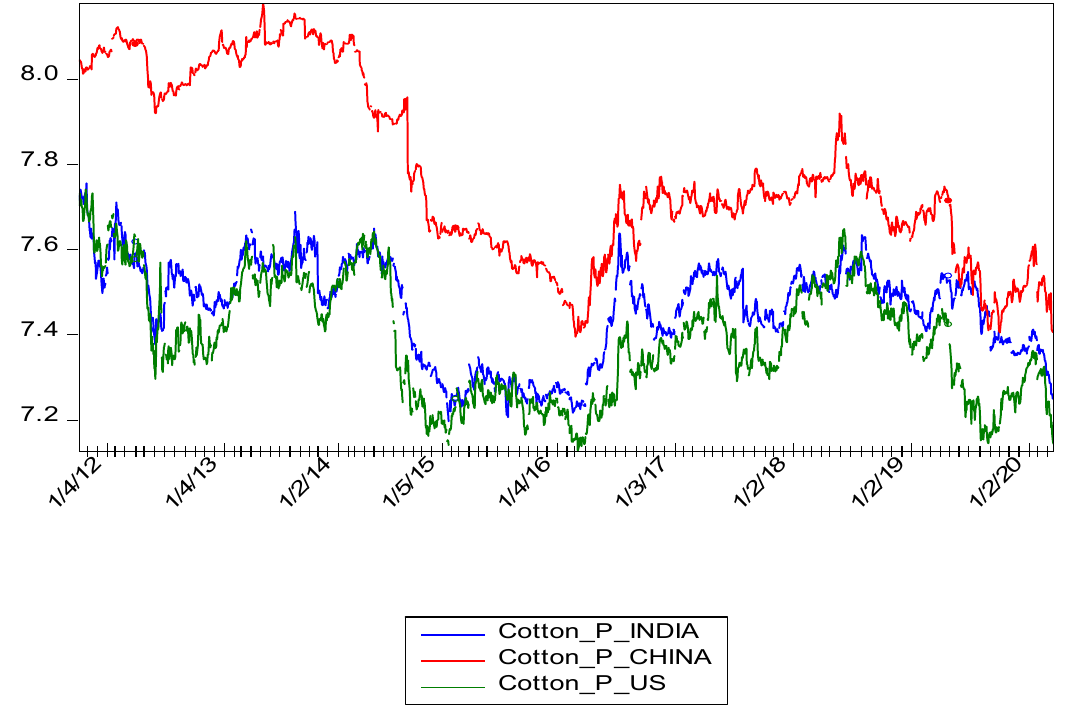
Figure 1. Natural Logarithms of Cotton futures price series in MCX Futures India, ICE Futures U.S., and Zhengzhou Commodity Exchange China.